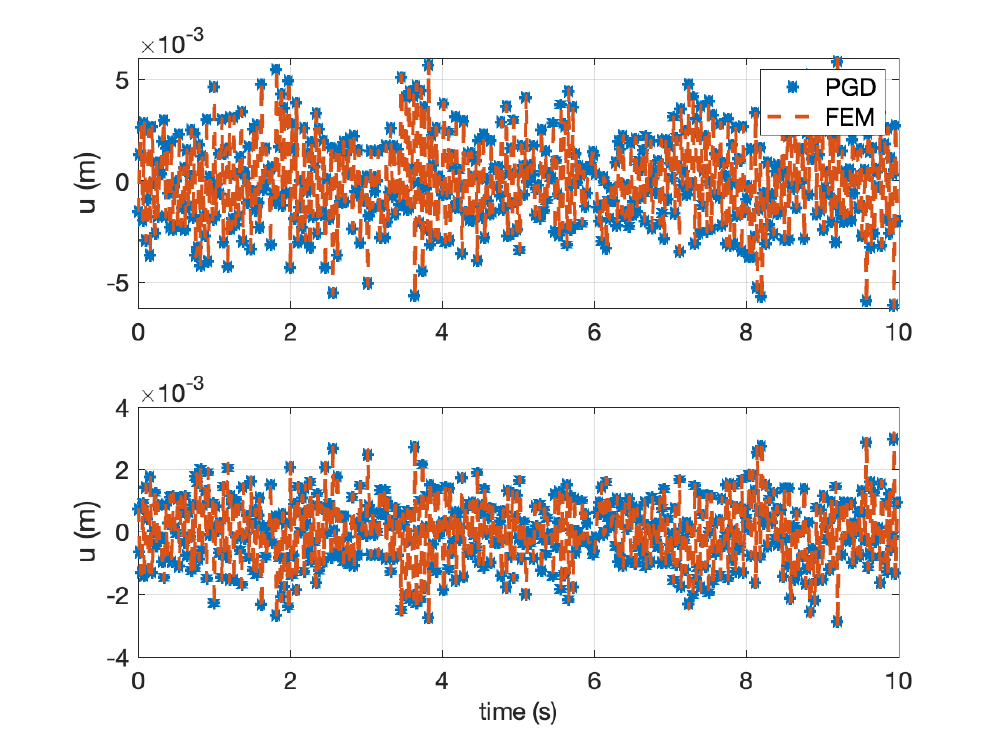
Figure 6. x-component of the displacement at the top of both layers: (top) top layer and (bottom) bottom layer.